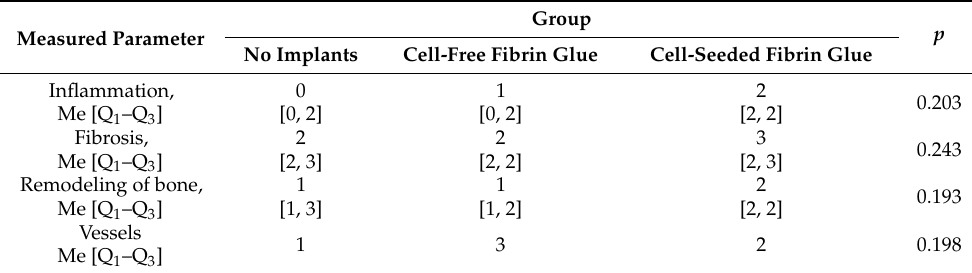
Table 2. Histomorphometric characteristics of